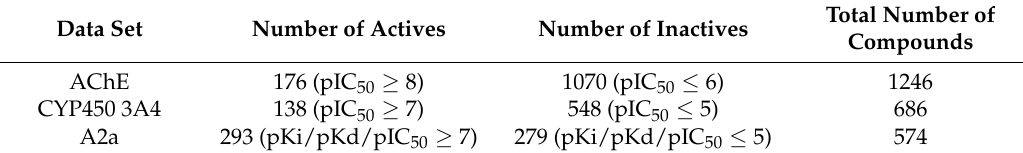
Table 1. Data sets used for ligand-based pharmacophore